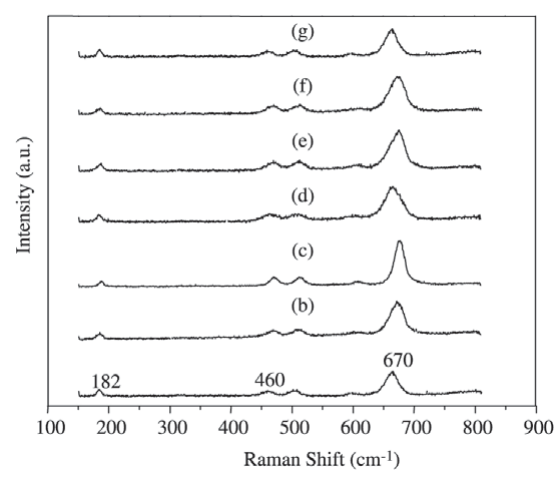
Figure 3. Raman Spectra of catalysts: a) 5Co; b) 0.5Ag/5Co; c) 1Ag/5Co; d) 9Co; e) 0.5Ag/9Co; f) 1Ag/9Co; g) Co